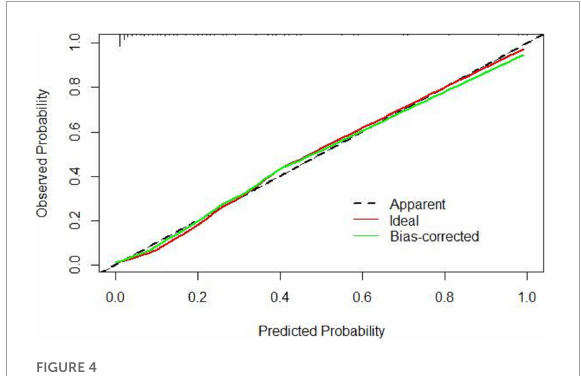
FIGURE4 The calibration diagram verified by bootstrap re-sampling showed excellent consistency.